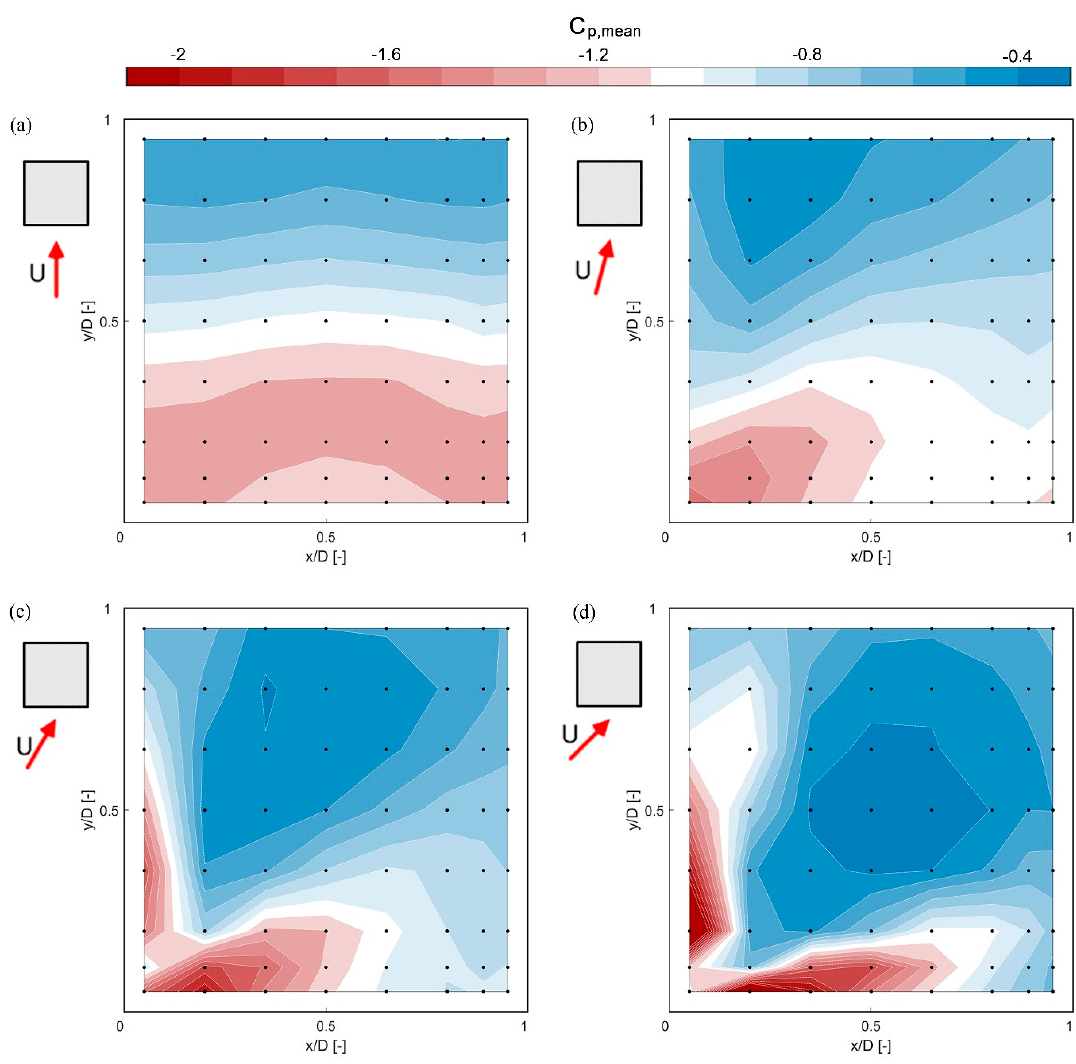
Figure 6. Mean surface pressure coefficient ( C p,mean ) distributions on the flat roof for different approaching flow angles: ( a ) 0°, ( b ) 15°, ( c ) 30° and ( d ) 45°. Black dots on the surface plot represent the measurement taps.